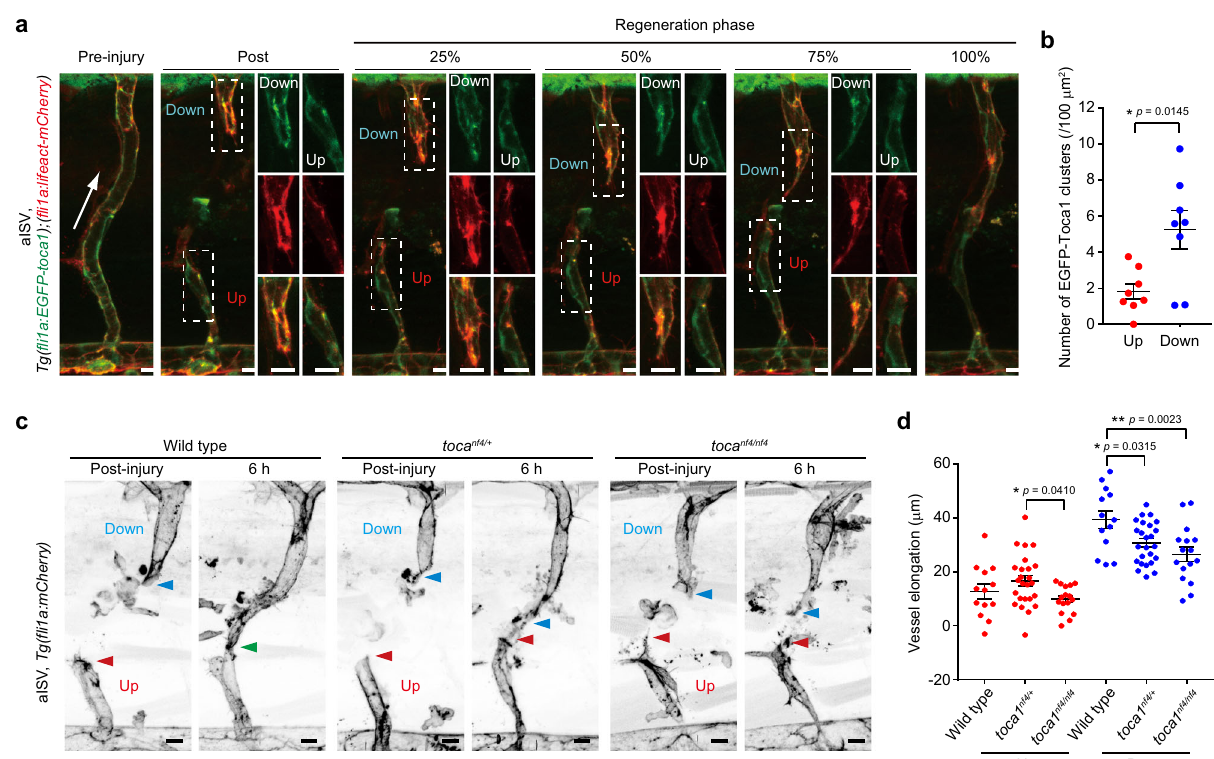
Fig. 9 IP load-induced EC stretching inhibits leading edge localization of Toca1 to suppress elongation of upstream injured vessels. a , b Localization of EGFP-Toca1 in injured aISVs. a Confocal z -projection images of pre- and post-injured aISVs in the Tg( fl i1a:EGFP-toca1);( fl i1a:lifeact-mCherry) larva at 3 dpf and its subsequent time-lapse images at the indicated stages of repair. Lateral view, anterior to the left. Images of EGFP-Toca1 (green) and Lifeact-mCherry (red) fl uorescence are merged. EGFP (top), mCherry (middle), and their merged (bottom) images corresponding to boxed areas are enlarged on the right. Arrow indicates blood fl ow direction. b Number of EGFP-Toca1 clusters colocalizing with Lifeact-mCherry-marked F-actin in vascular regions within 20 µ m from the leading edge at approximately 25% reparative phase. Each dot represents an individual injured vessel (red and blue, upstream and downstream injured vessels, respectively). Data are means ± s.e.m. ( n = 8 animals for each). * p < 0.05 by Welch ’ s two-sided t test. c , d Elongation of injured aISVs in toca1 mutant zebra fi sh. c Confocal z -projection images of injured aISVs and those after 6 h in wild-type (left), toca1 nf4/ + (middle), and toca1 nf4/nf4 (right) larval zebra fi sh at 3 dpf with Tg( fl i1a:lifeact-mCherry) background are as in a . Red and blue arrowheads, leading edges of upstream and downstream injured vessels, respectively; green arrowhead, anastomotic site of the injured vessel. d Quanti fi cation of elongation lengths of upstream and downstream injured aISVs in wild type, toca1 nf4/ + , and toca1 nf4/nf4 embryos, as in c . Each dot represents an individual larva (red and blue, upstream and downstream injured vessels, respectively). Data are means ± s.e.m. (wild type, n = 13; toca1 nf4/ + , n = 25; toca1 nf4/nf4 , n = 16). * p < 0.05, ** p < 0.01 by one-way ANOVA followed by Tukey ’ s test among the upstream or downstream group. Source data are provided as a Source data fi le. Scale bars: 10 µ m ( a , c ), 5 µ m (enlarged images in a